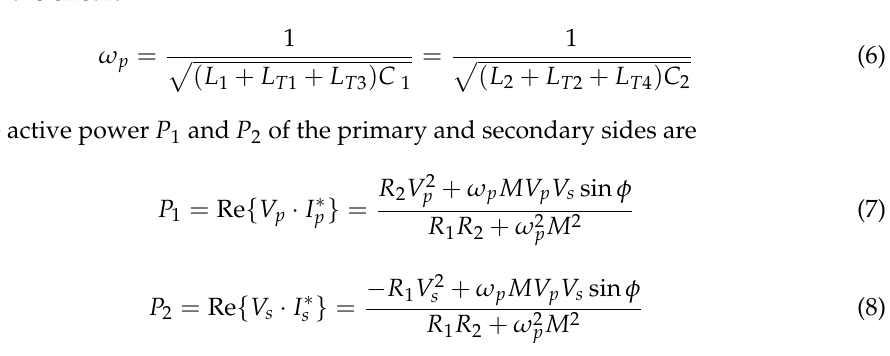
Figure 3. The schematic diagram of the SWIPT system equivalent circuit. The power transfer frequency is necessary to work at the circuit resonance frequency. C 1 and C 2 compensate the inductance of the primary and secondary coils. The power res- onant angular frequency ɷ p is obtained from the inductance and compensation capaci- tance values in the circuit.